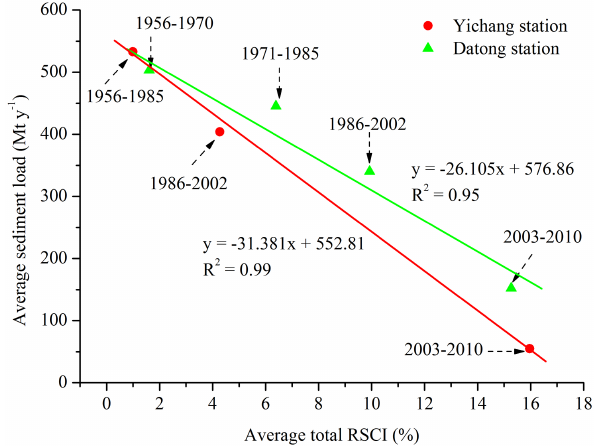
Figure 3. The relationship between average sediment load and total RSCI of different periods at the Yichang and Datong